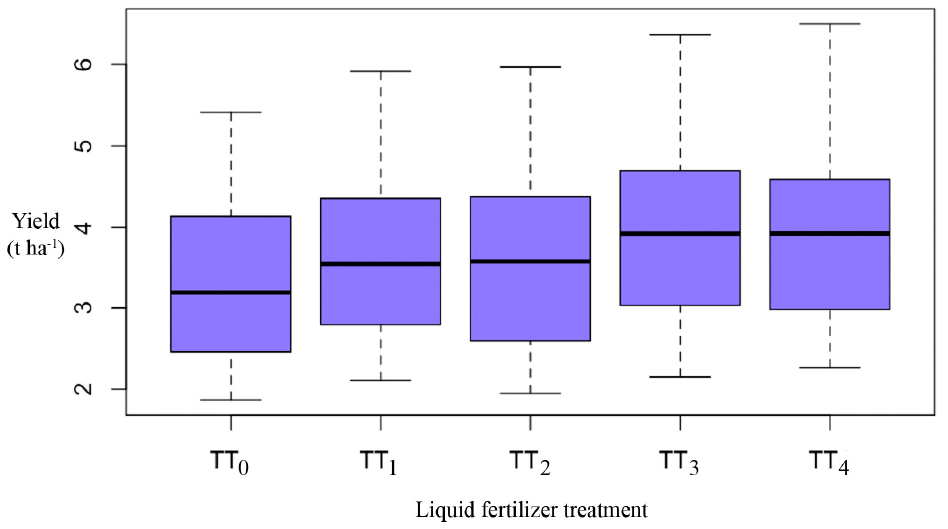
Figure 6. Yield values depending on the amount of applied starter fertilizer.